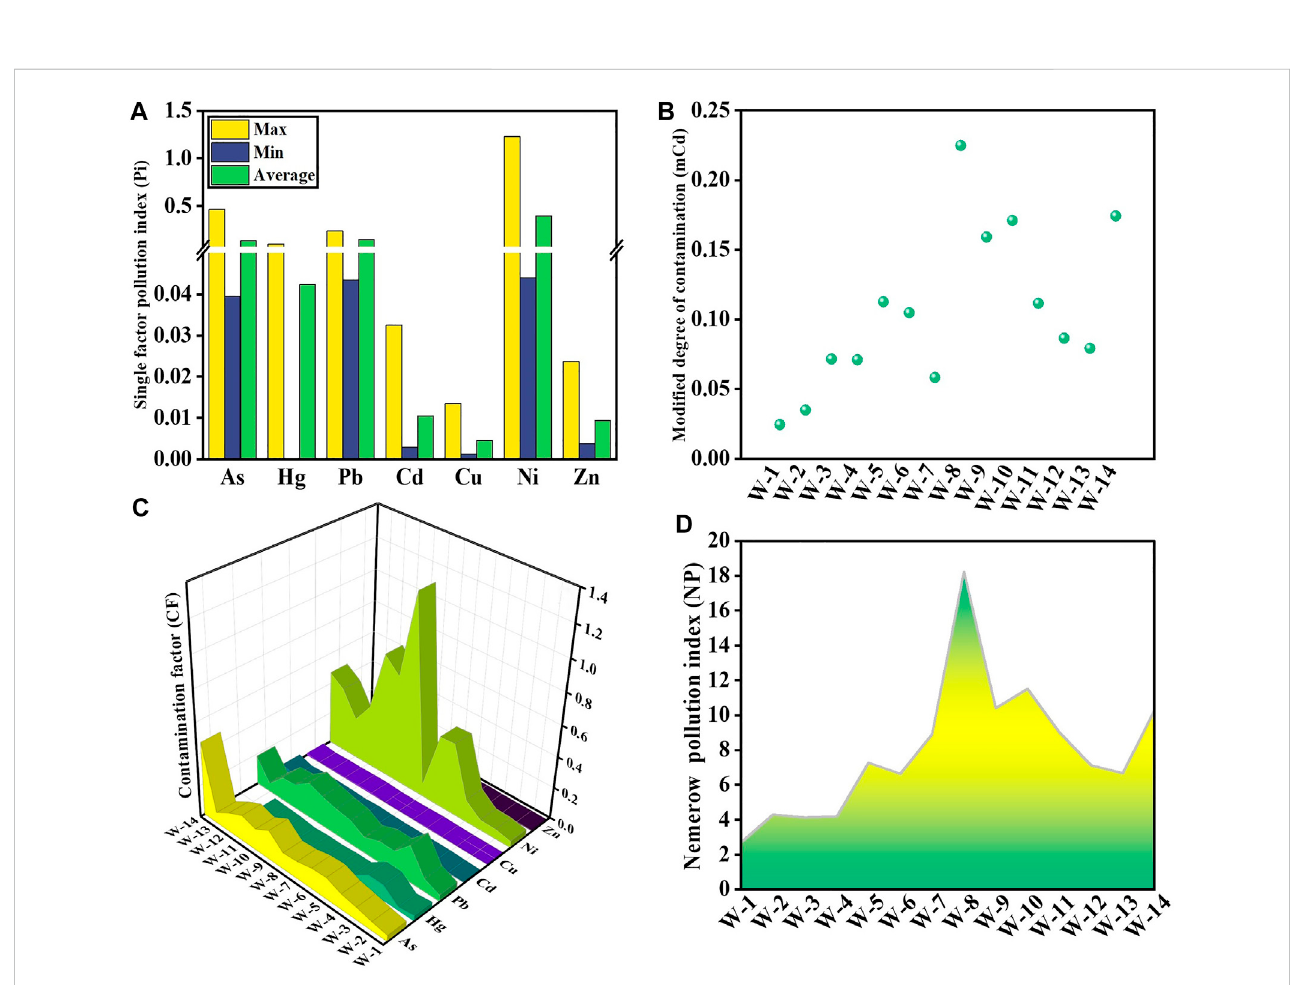
FIGURE 3 Pi (A) , mCd (B) , CF (C) , and NP (D) in the surface water of the Golmud